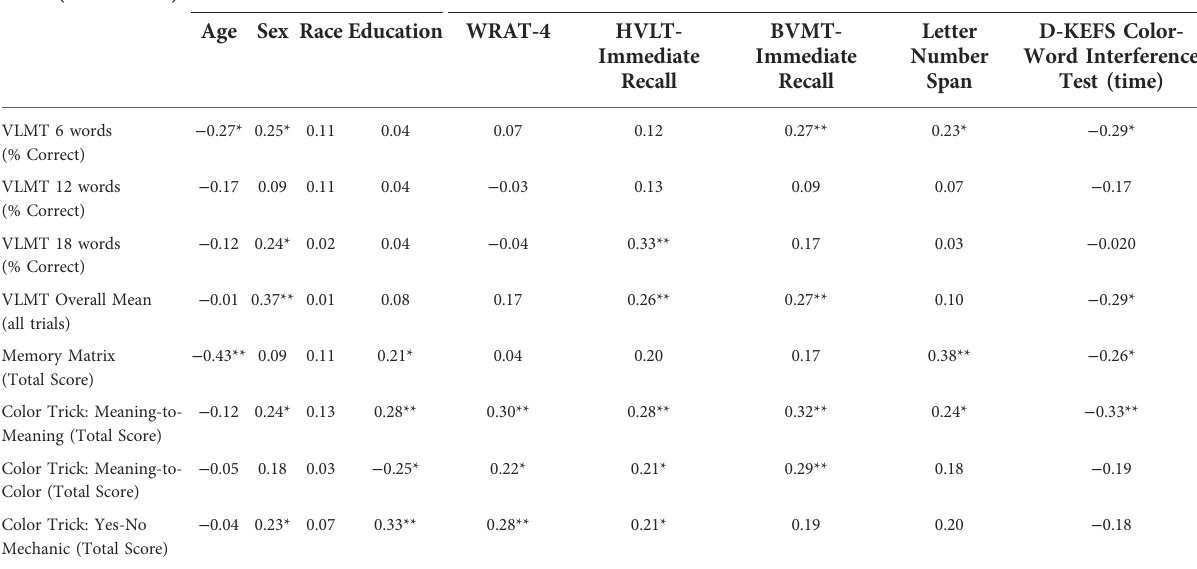
TABLE 4 Correlations between mobile cognitive tests and in-lab neuropsychological performance in whole sample ( N =94). Mobile Cognitive Tests (Raw